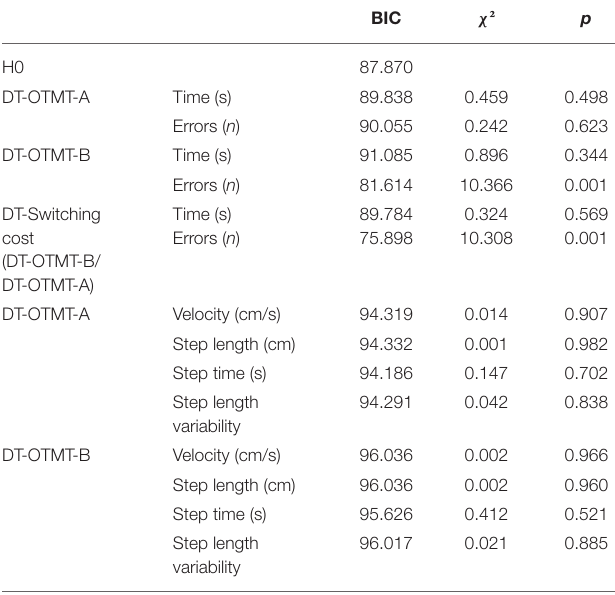
TABLE 5 | Characteristics of the logistic regression model of cognitive and gait performances under DT conditions.